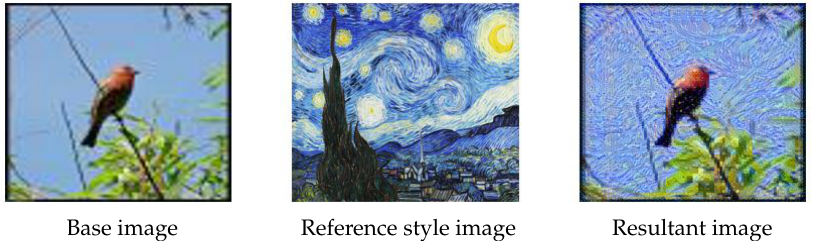
Figure 12. Data augmentation by texture transfer. Content of the base image ( left ) is mixed with the style of the reference style image ( middle ) to obtain the resultant image ( right ).